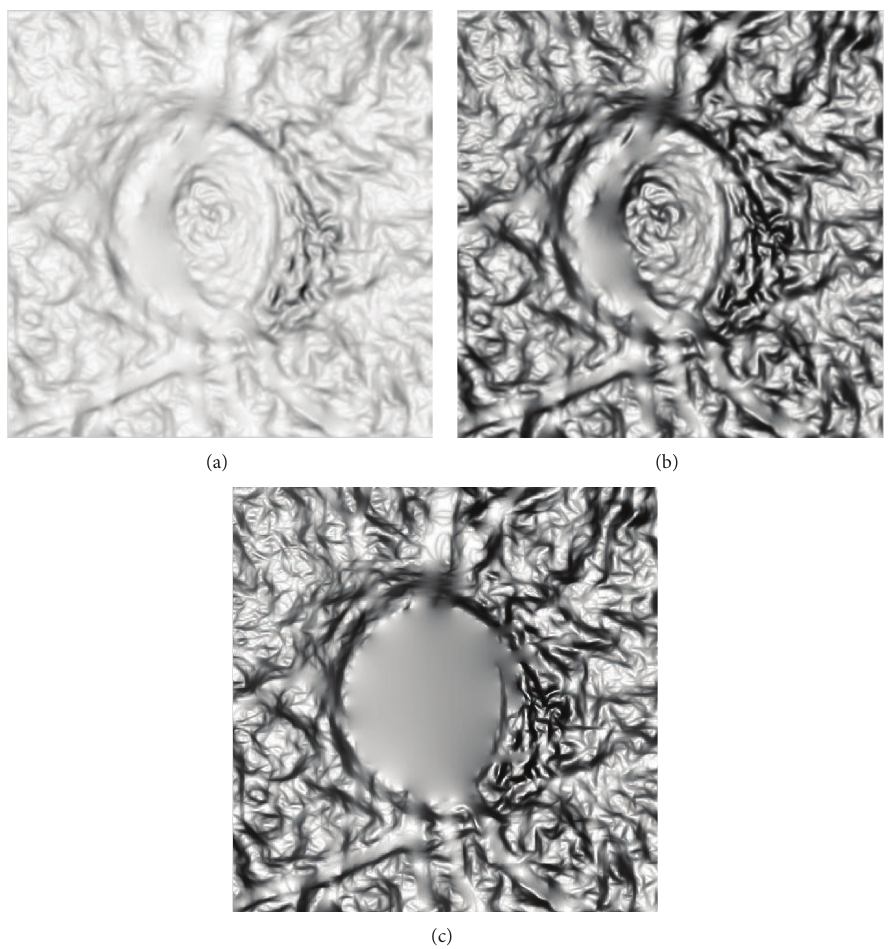
Figure 11: Texture noise removal. (a) Image texture. (b) After enhancement. (c) After noise